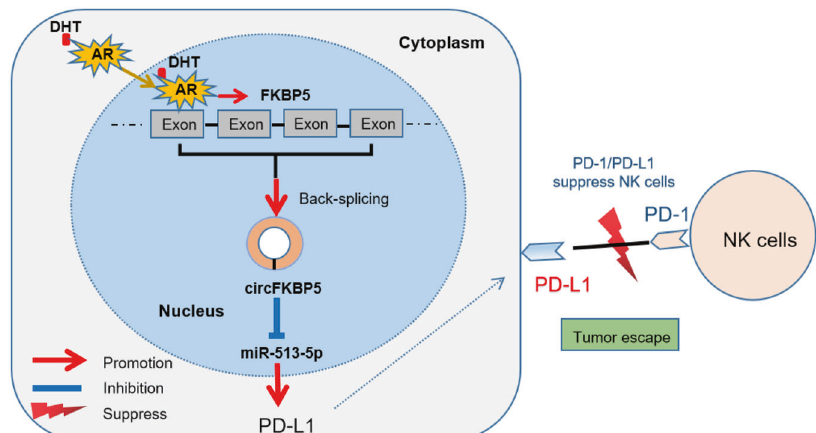
Fig. 8 A mechanistic diagram. A mechanistic diagram for DHT suppression effect on NK cells immunotherapy ef fi cacy towards CRPC cells.